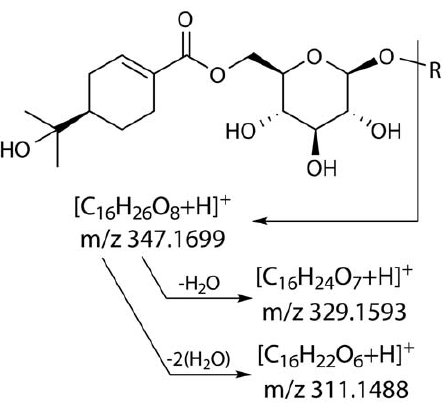
Figure 2. MS 2 fragmentation of oleuropeyl glucose esters resulting in diagnostic C 16 fragments.